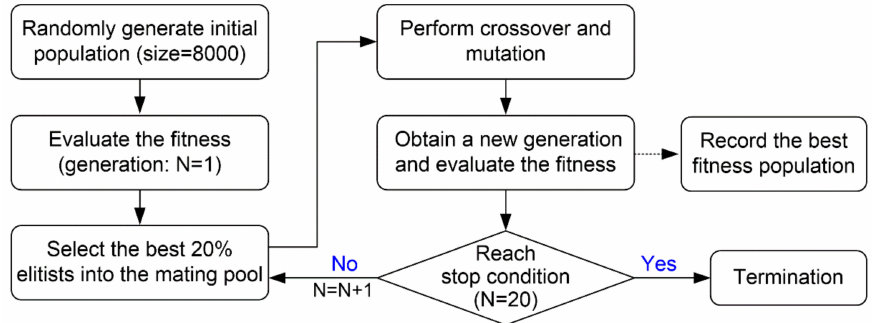
Figure 4. Flowchart of the determination of the optimal weights using GA in the Past step.